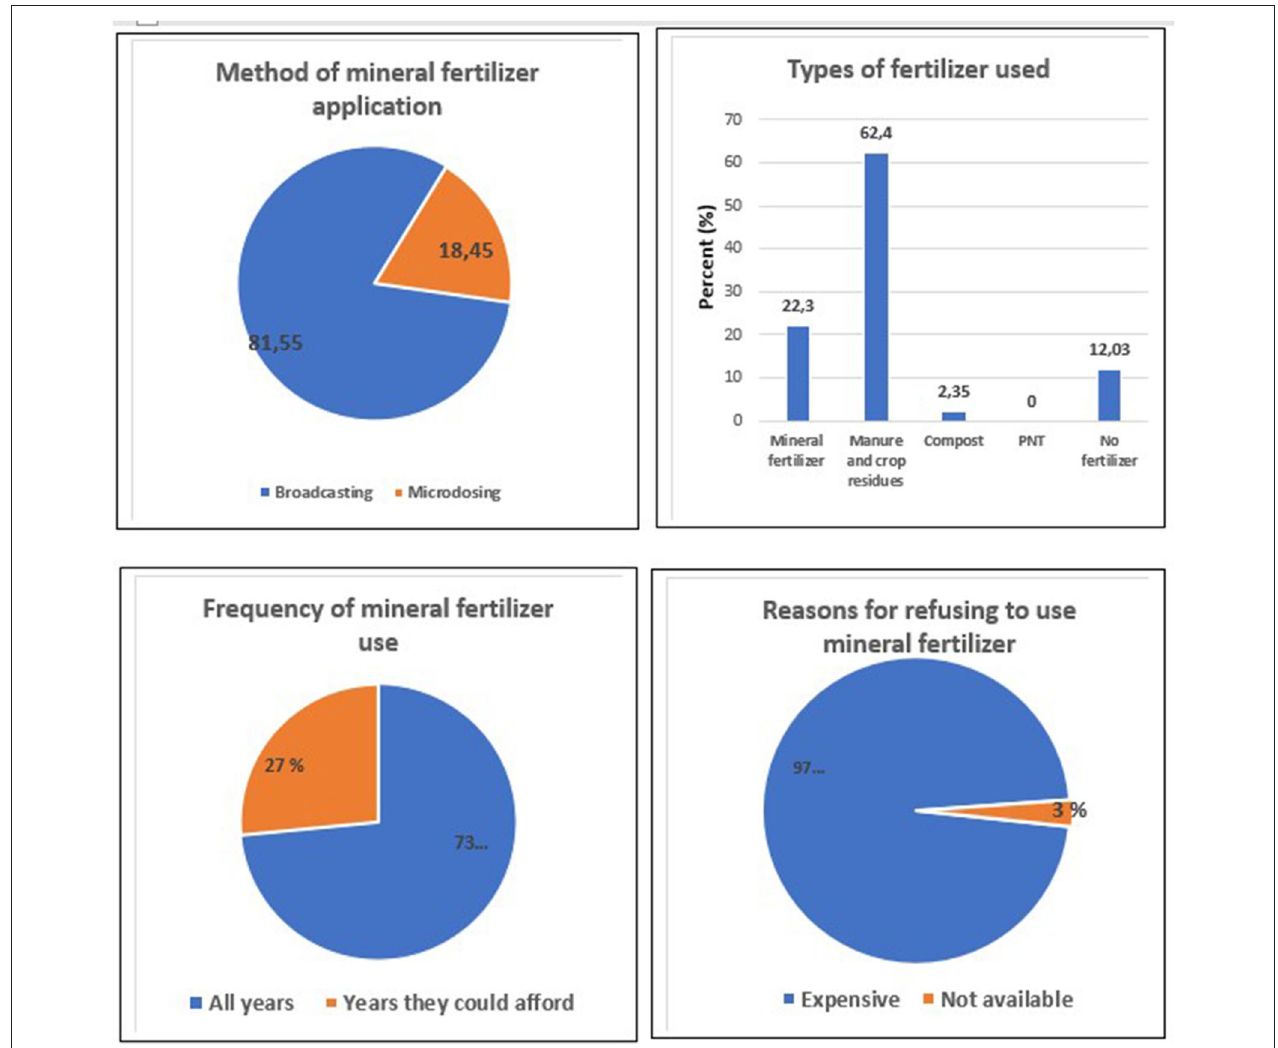
FIGURE 5 | Method of mineral fertilizer application, types of fertilizer use, frequency of mineral fertilizer use, and reasons for refusing to use mineral fertilizer.